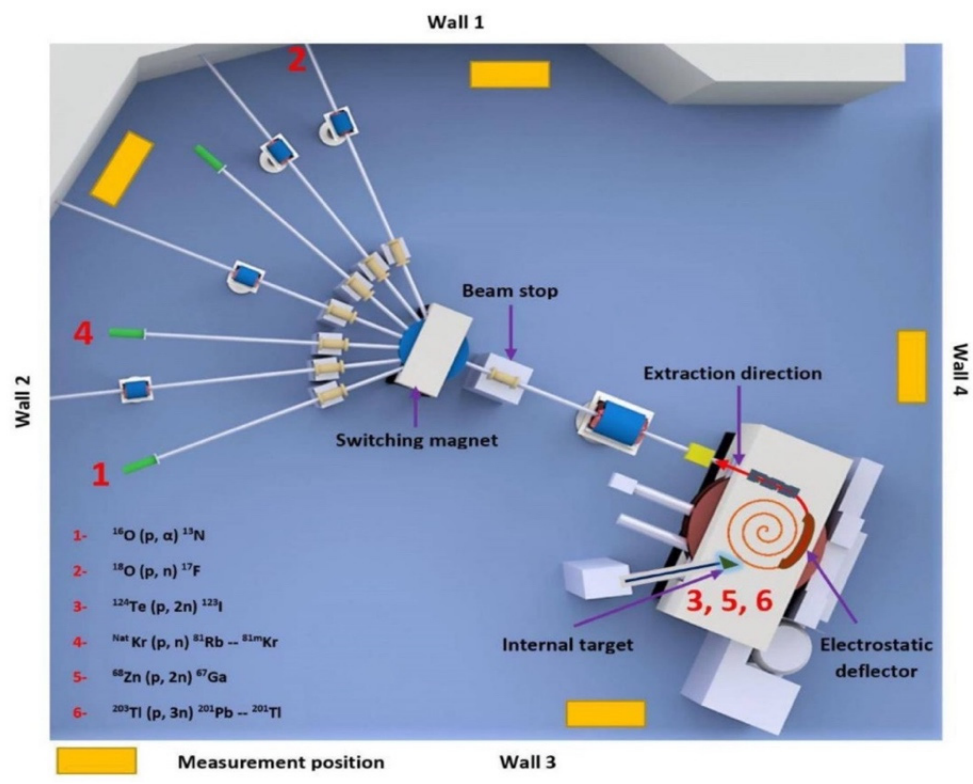
Figure 1. Layout of the CS-30 vault. Table 1. Chemical composition of the CS-30 cyclotron’s concrete